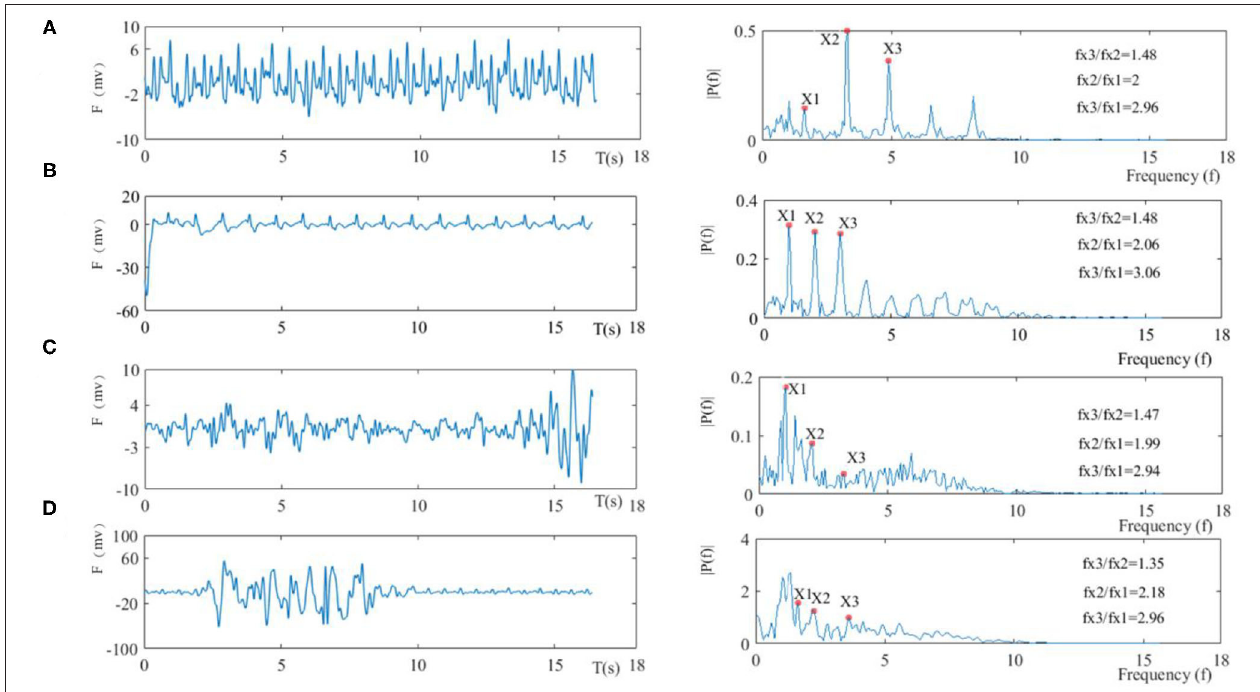
FIGURE 9 | Four types of BCG waveforms (the left side) and spectra (right side), in which the fundamental frequency is X1,the second harmonic is X2,and the third harmonic is X3, (A) in the normal resting state, (B) in the holding breath, (C) in the case of slow respiration, and (D) in the moving